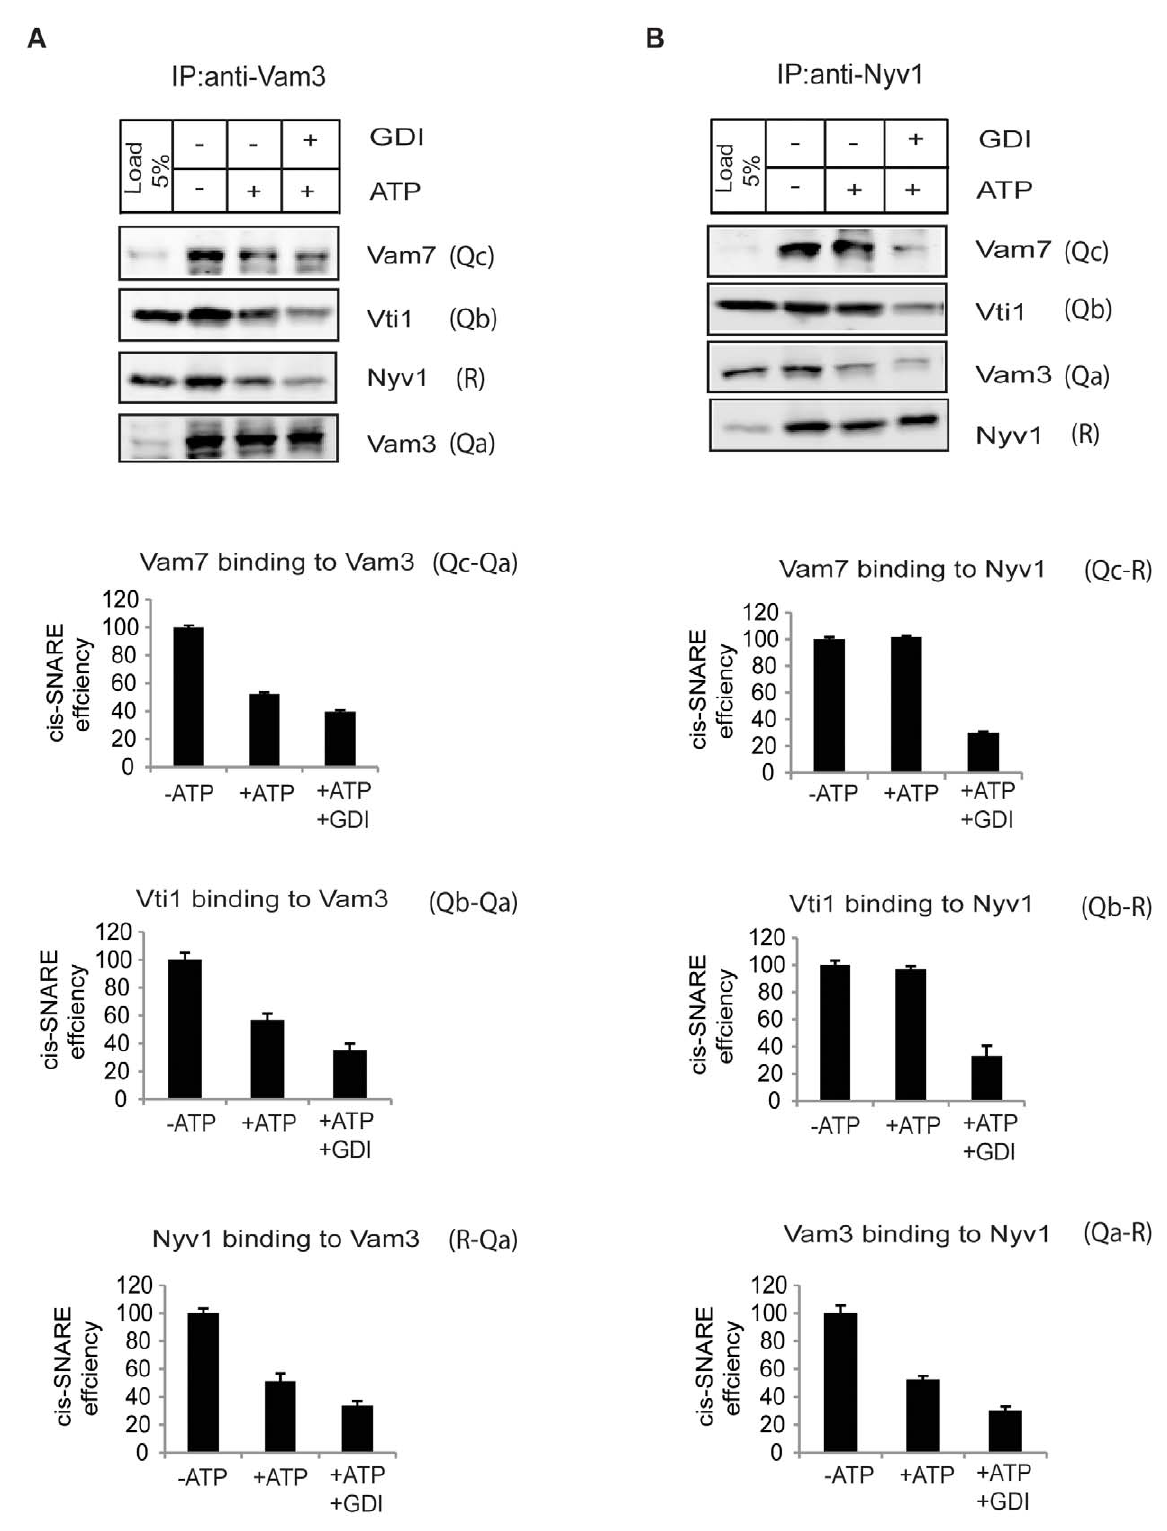
Figure 3. Q bc R-complex formation during the priming reaction. Vacuoles from wildtype cells were incubated under standard fusion conditions in the presence or absence of ATP and GDI. After 5 min of incubation at 27 u C, vacuoles were solubilized with Triton X-100 and immunoadsorbed to anti-Vam3 (Figure 3A) or anti-Nyv1 (Figure 3B) protein A beads. Bound proteins were separated by SDS-PAGE, blotted, and probed with indicated antibodies. The efficiency of Q abc complex formation was determined as co-precipitation of Vam7 and Vti1 with Vam3; the efficiency of Q bc R complex formation was determined as co-precipitation of Vam7 and Vti1 with Nyv1 in wildtype vacuoles and standardized to the 2 ATP amount. The percentages of the + ATP and + ATP/GDI values were calculated. The quantification of protein band in Western blot was done by Odyssey densitometry. Five independent experiments are shown as 6 SD. doi:10.1371/journal.pbio.1001243.g003 PLoS Biology | www.plosbiology.org